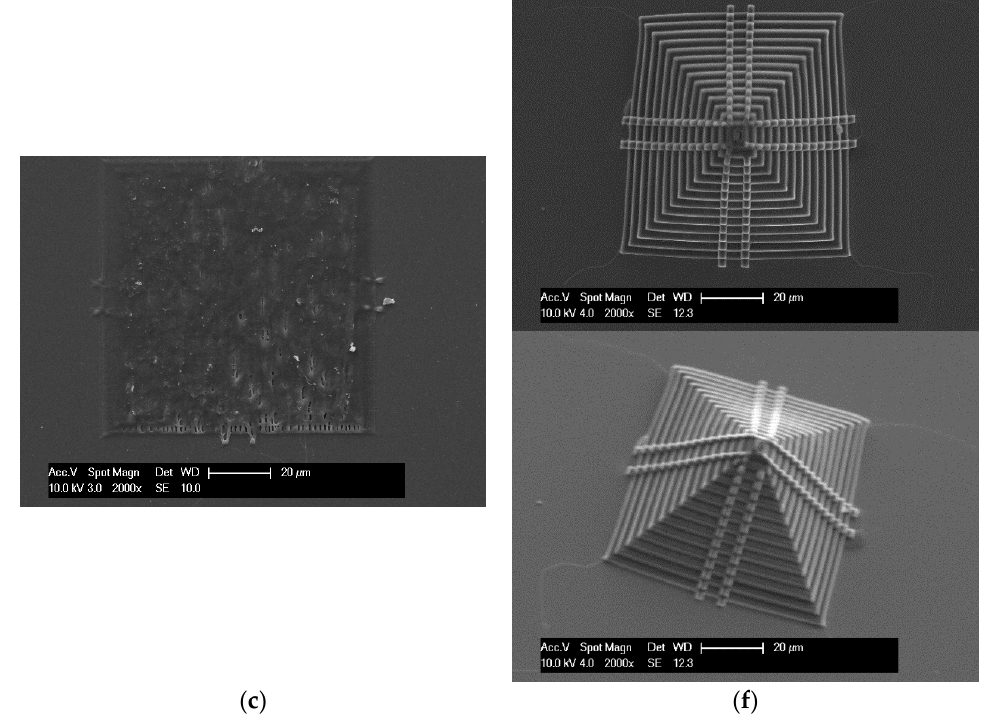
Figure 4. SEM images of 2D and 3D fabricated structures using Formulations 3 and 6. ( a – c ) show the results of fabricating increasingly more complex structures with Formulation 3 (Table 1); ( d – f ) show the results of fabricating increasingly more complex structures with Formulation 6; ( f ) shows both plan view and at a tilt angle of 30°.